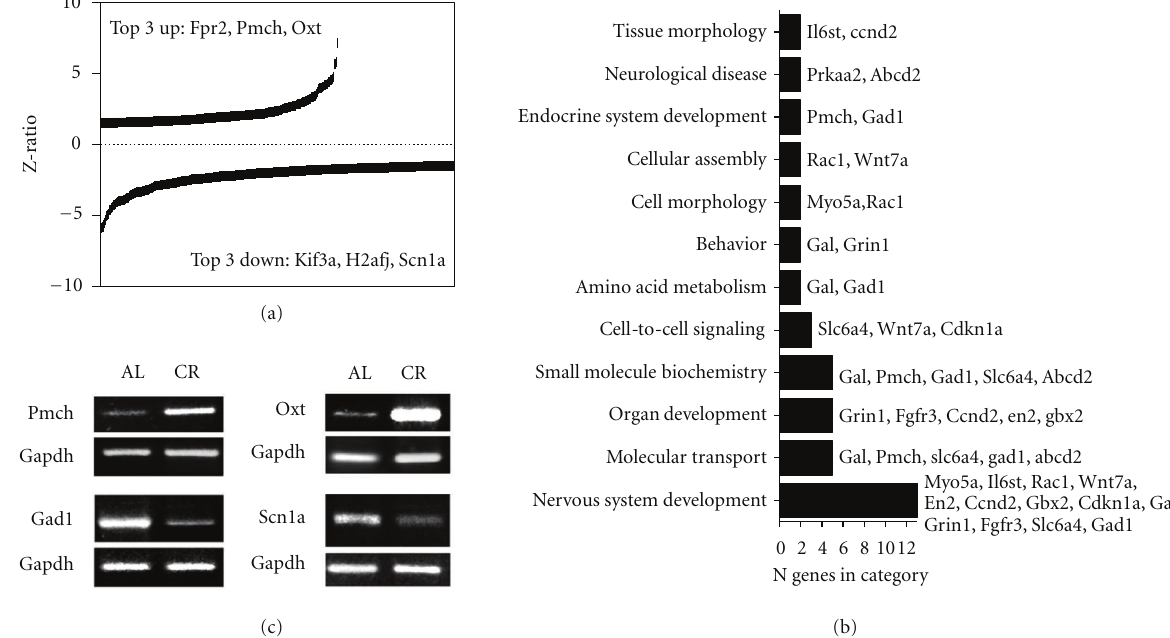
Figure 7: CR activates a diverse set of transcripts and pathways in db/db mice. (a) Z -ratios for genes that were up- or downregulated following CR in db/db mice. Fpr2, formyl peptide receptor 2; Pmch, pro-melanin-concentrating hormone; Oxt, oxytocin; Kif2a, kinesin family member 2A; H2afj, H2A histone family, member J; Scn1a, sodium channel, voltage-gated, type I, alpha. (b) Pathway analysis of genes responsive to restricted feeding in leptin receptor-deficient mice. Abbreviations: Il6st, interleukin 6 signal transducer; Ccnd2, cyclin D2; Prkaa2, protein kinase, AMP activated, alpha 2 catalytic subunit; Abcd2, ATP-binding cassette, subfamily D member 2; Pmch, pro-melanin-concentrating hormone; Gad1, glutamic acid decarboxylase 1, Rac1, RAS-related C3 botulinum substrate 1; Wnt7a, wingless-related MMTV integration site 7A; Myo5a, myosin VA; Gal, galanin; Grin1, glutamate receptor, ionotropic, NMDA1; Slc6a4, solute carrier family 6 member 4; Cdkn1a, cyclin-dependent kinase inhibitor 1A; Fgfr3, fibroblast growth factor receptor 3; En2, engrailed 2; Gbx2, gastrulation brain homeobox 2. (c) PCR validation of di ff erences in gene expression after CR in db/db mice.